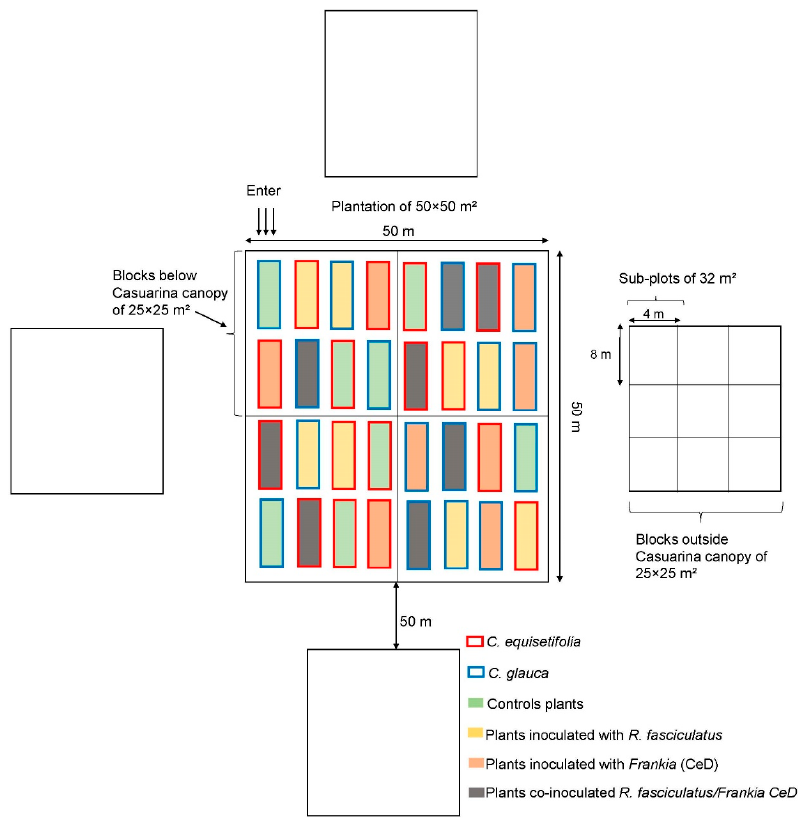
Figure 2. Experimentation design .